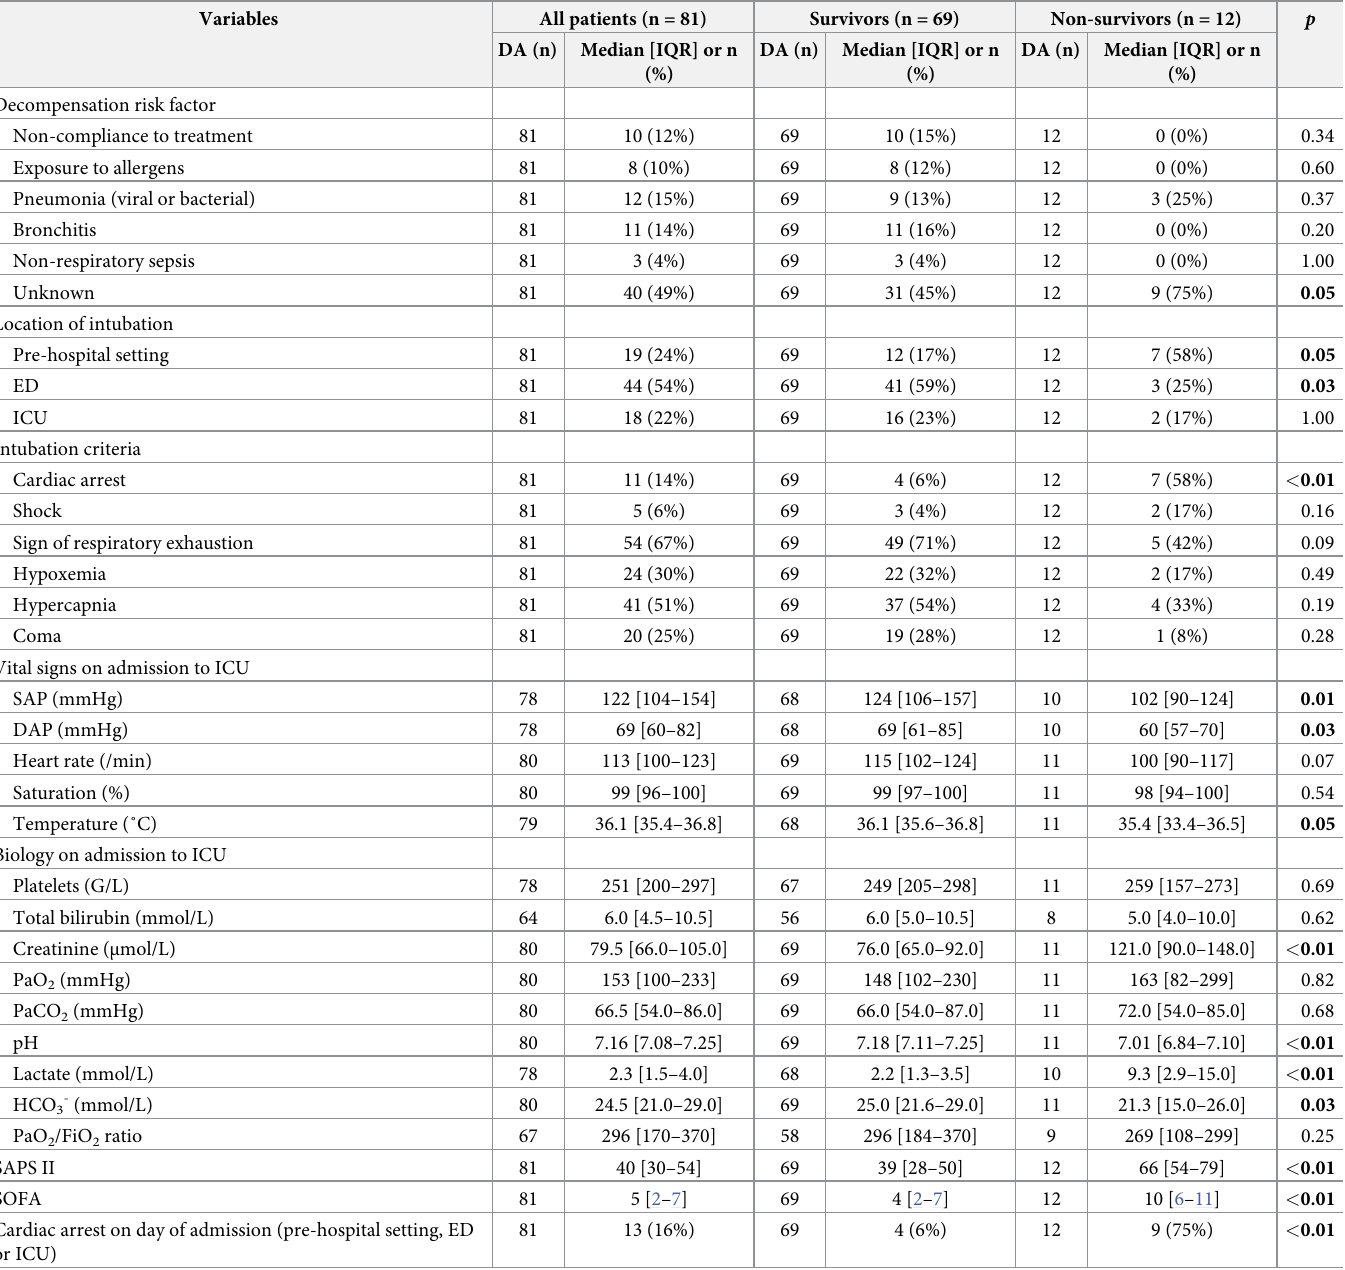
Table 2. Characteristics of patients and organ failure on the day of admission according to in-hospital survival status.